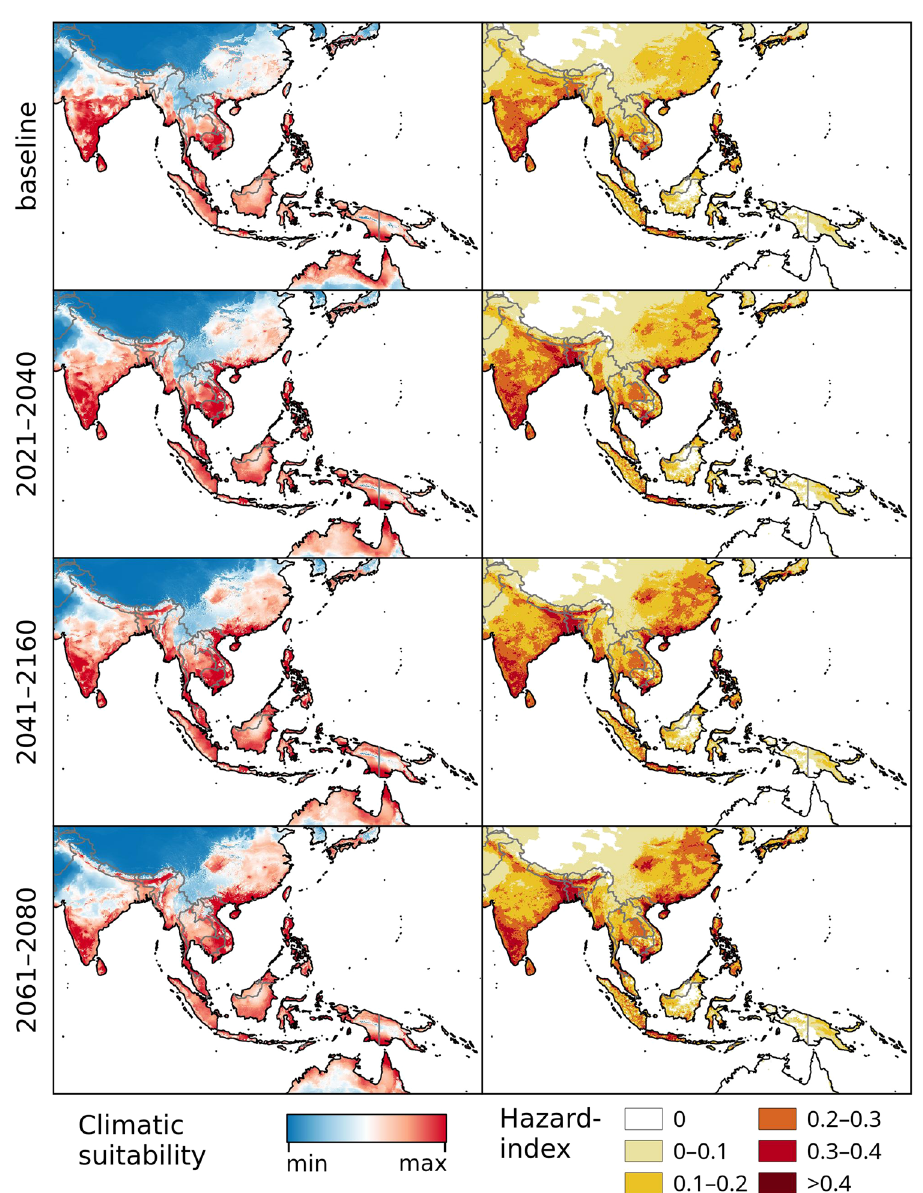
Figure 1. Chikungunya under the baseline and RCP 8.5 climate change scenarios in Asia and Australasia. Left: Climatic suitability, right: hazard index. Climate change scenarios represent the mean model output obtained through the 5 GCMs. Climatic suitability output is scaled to the over-all global minimum (0) and maximum (0.623) values observed in any model. Maps were generated using the “raster” package in R 3.3.2 (https://www.r- project.org/) and QGIS 2.8.1